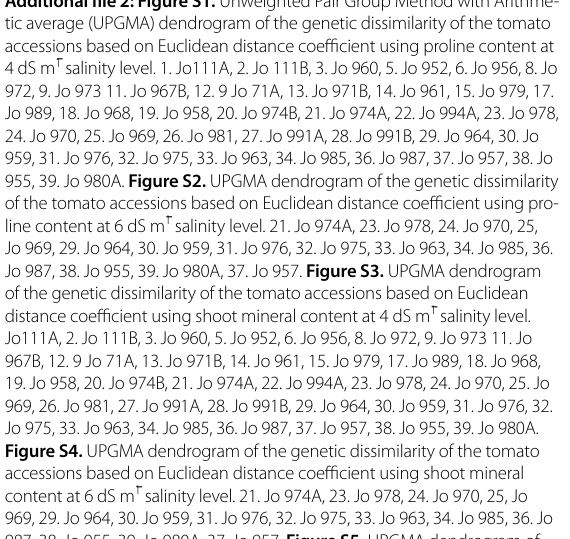
Figure S4. UPGMA dendrogram of the genetic dissimilarity of the tomato accessions based on Euclidean distance coefficient using shoot